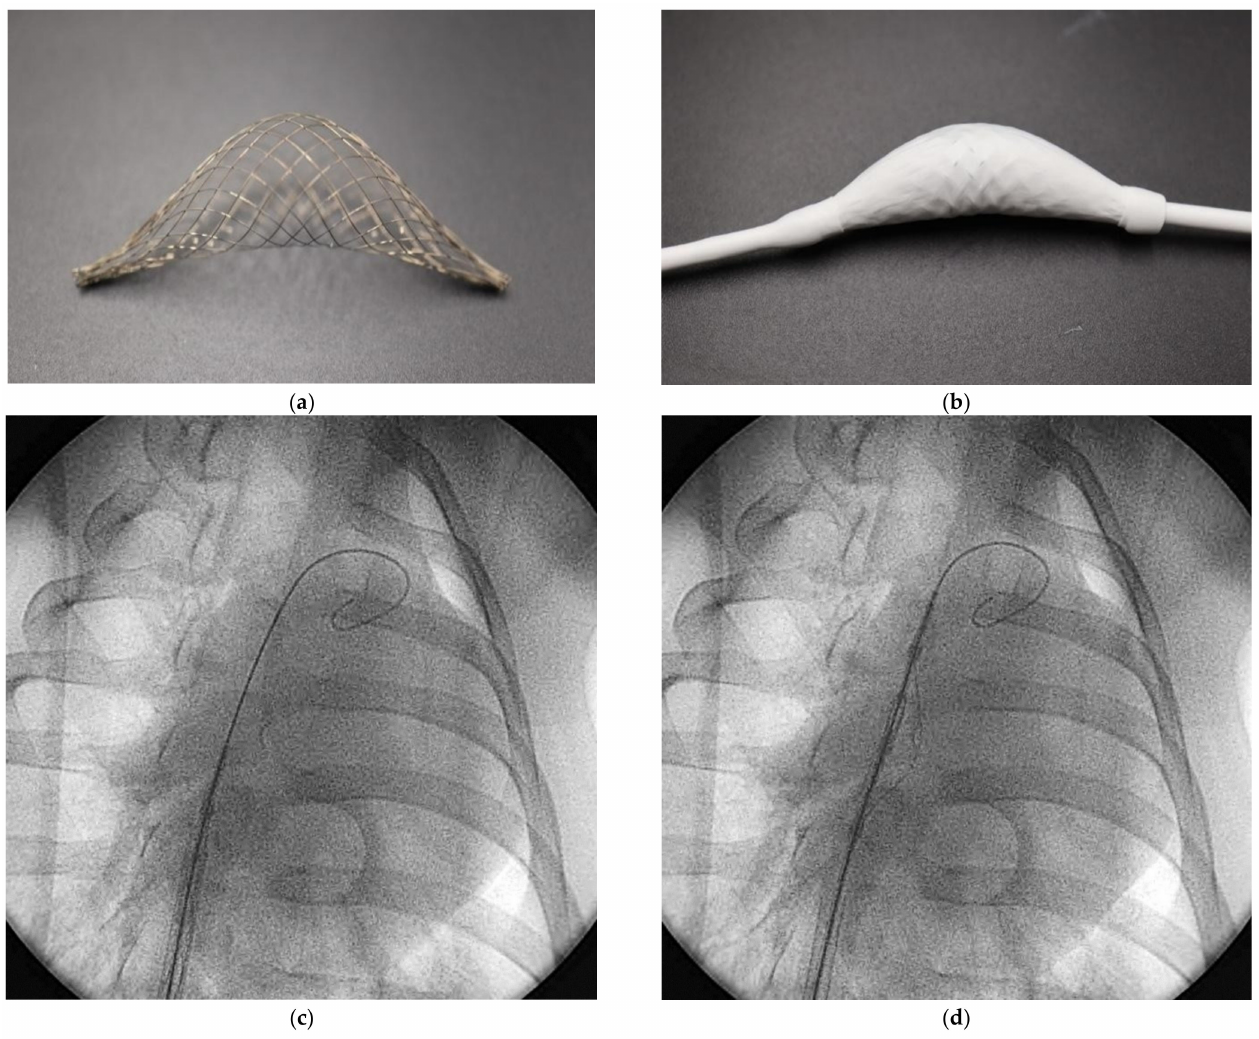
Figure 1. Self-expendable mesh spacer. The length of the spacer is 45–50 mm, and the diameter is 12.4 ± 1.5 mm. For its expansion, the inner mesh was pre-shaped ( a ) and then ePTFE-coated ( b ) in advance. The spacer is delivered with the introducer sheath loaded and deployed without additional fluid filler injection. ( c , d